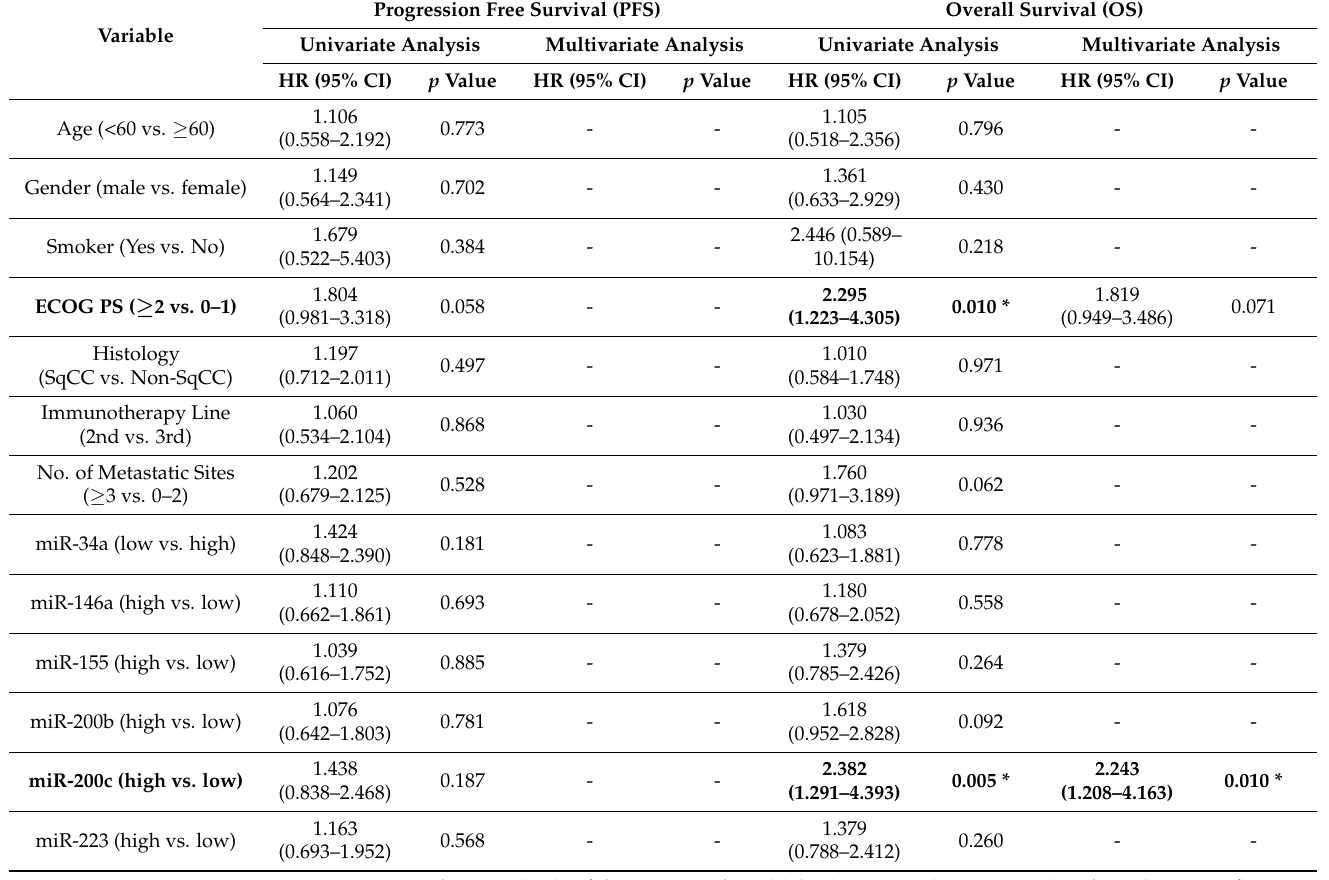
Table 3. Univariate and Multivariate Cox Regression Analysis for Progression Free Survival (PFS) and Overall Survival (OS) in Patients with Advanced NSCLC (N = 69) Treated with Nivolumab.